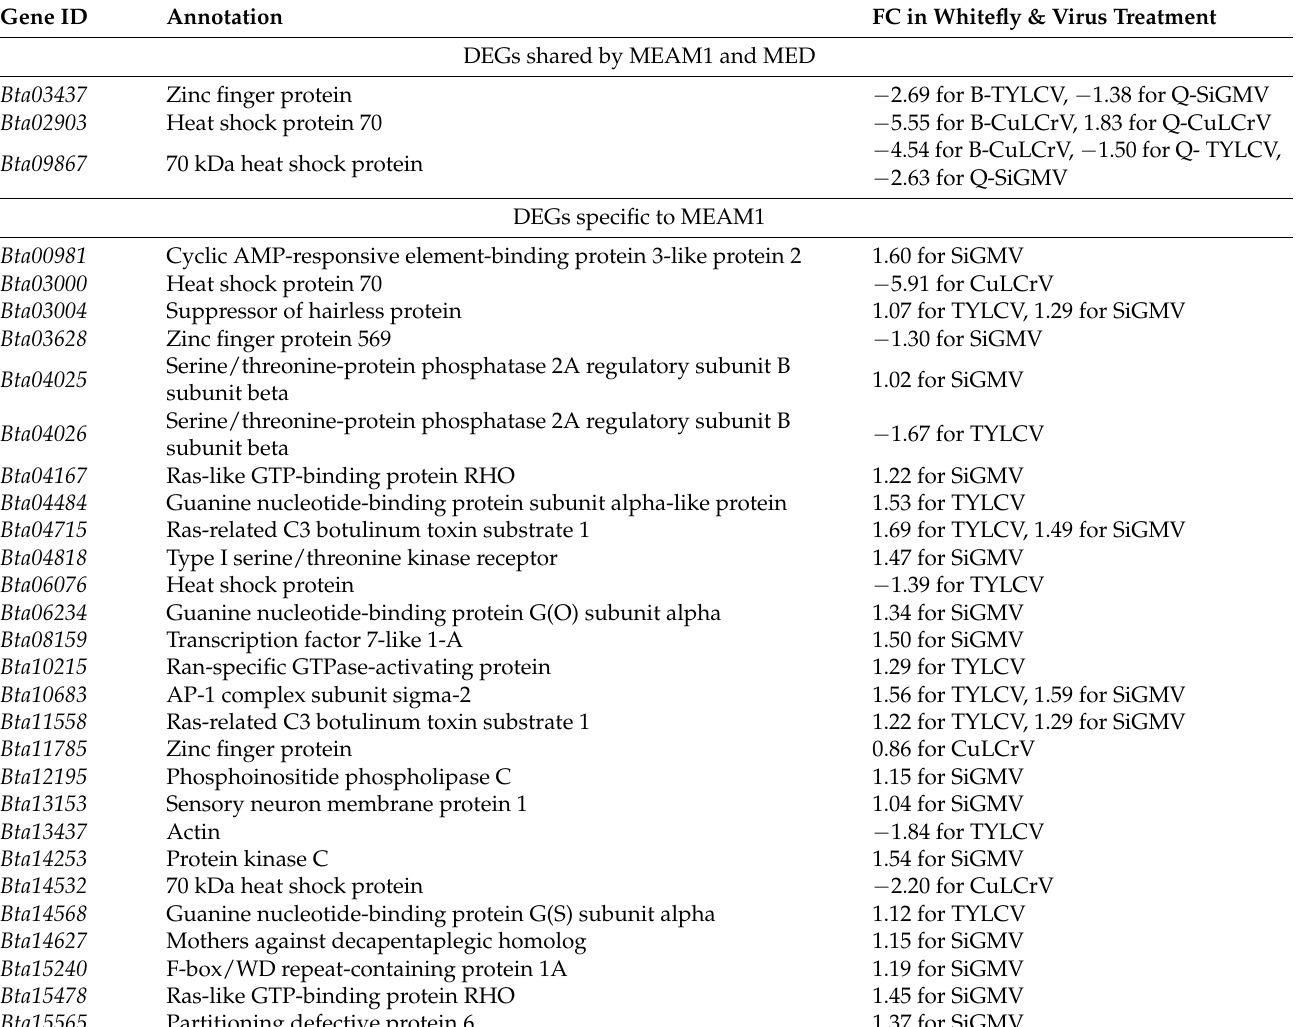
Table 2. Differential expression of genes associated with virus infection in viruliferous Bemisia tabaci Middle East-Asia Minor 1 (MEAM1) and Mediterranean (MED) adults compared with non- viruliferous